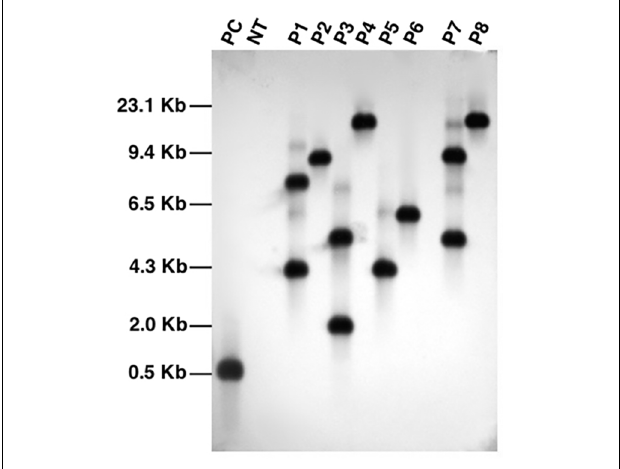
FIGURE 4 | Southern blot analysis of PCR characterized transgenic events using bar gene specific probe. Lanes, PC: plasmid pCWAK-ipk2 (positive control); NT: genomic DNA from non-transformed plant (negative control); P1-P8: genomic DNA of independent transgenic events showing hybridization signals indicating transgene integration.